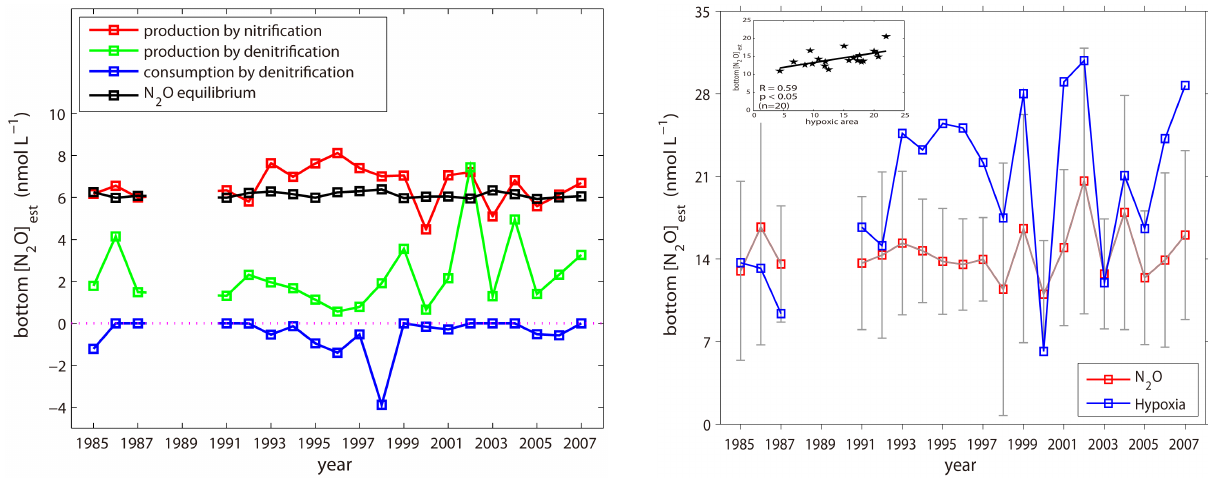
Fig. 4. Interannual variations in summer (July) bottom-water N 2 O concentration (nmolL − 1 , red squares) and the areal extent of hy- poxia (km 2 , blue squares). The estimated bottom-water N 2 O con- centrations were significantly correlated with the areal extent of hypoxia ( R = 0.59; p < 0.05 with n = 20). Data concerning the areal extent of hypoxia are available at http://www.gulfhypoxia. net/Research/Shelfwide%20Cruises/ (data source: N. N. Rabalais, Louisiana Universities Marine Consortium, R. E. Turner, Louisiana State